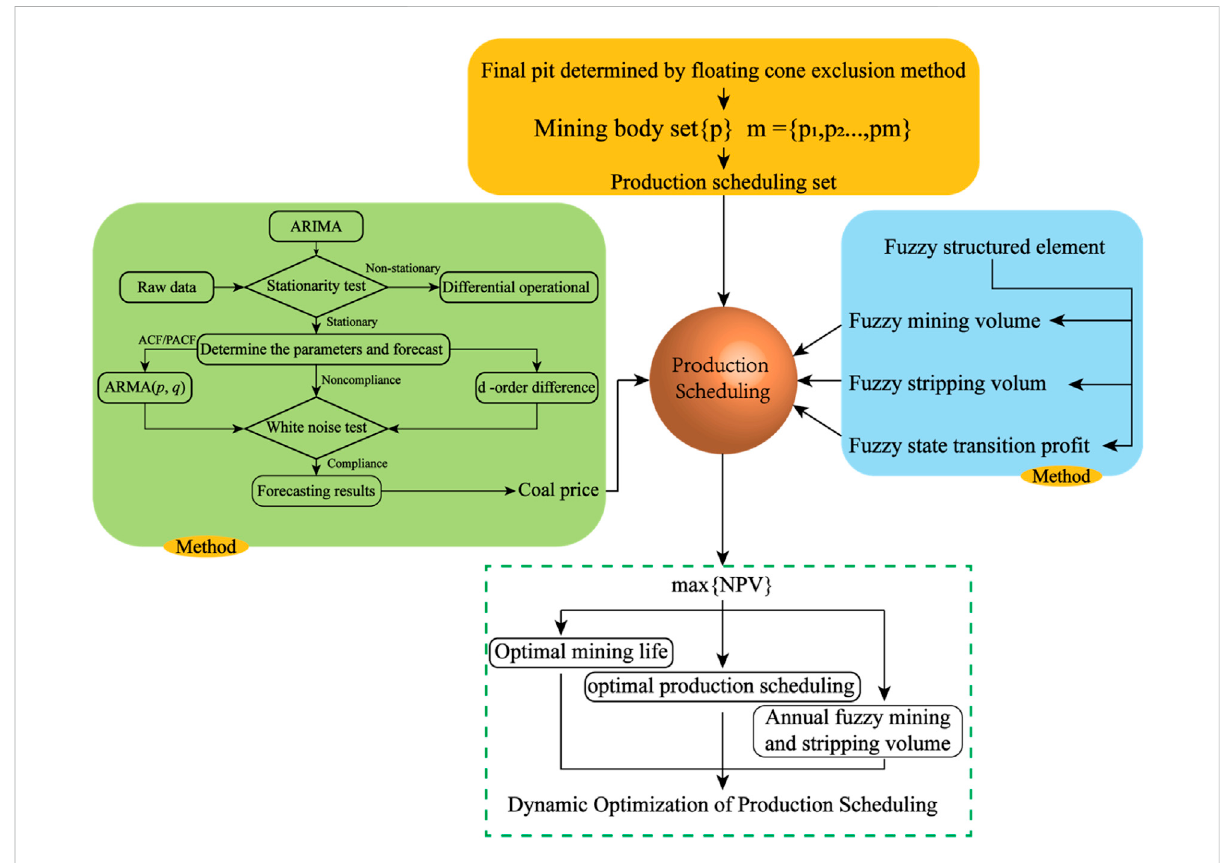
FIGURE 4 Dynamic optimization of OPCMPS fl